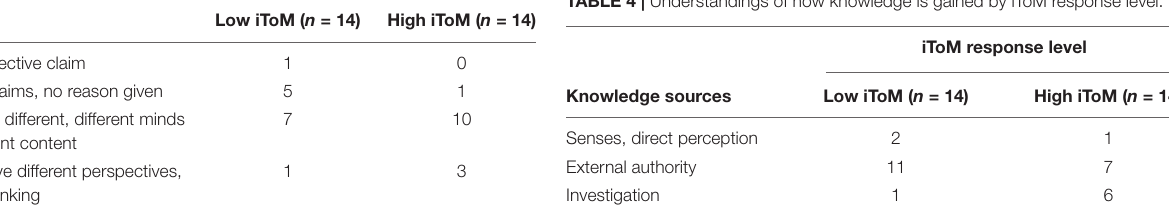
TABLE 4 | Understandings of how knowledge is gained by iToM response